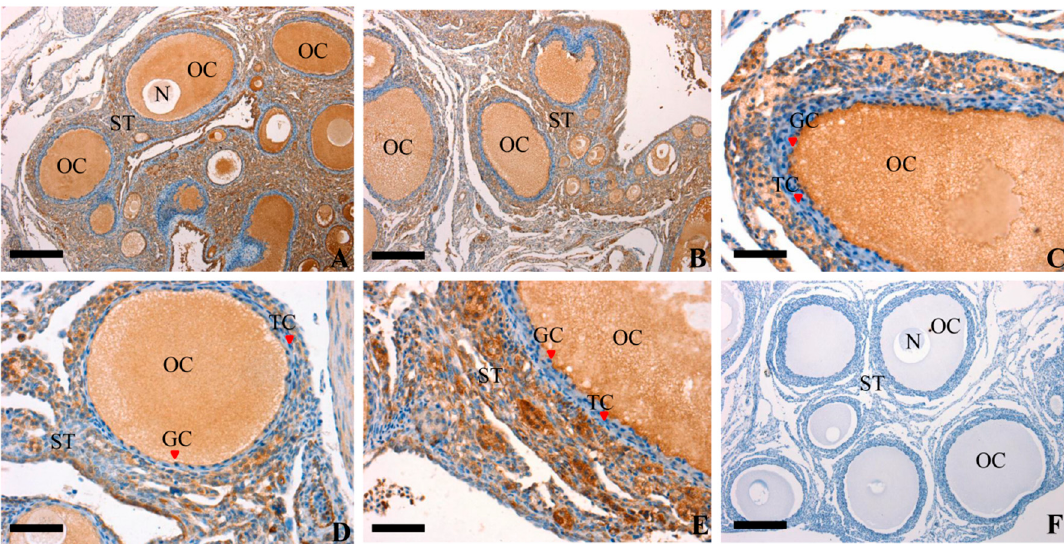
Figure 2. Representative photomicrographs of RAC1 protein immunolocalization (in brown) in the prehierarchical follicle of ovarian. Panel ( A ) and ( B ), oocytes and GCs were strongly stained within the different size of prehierarchical follicles; Panel ( C ) and ( D ), a larger developing prehierarchical follicles, which contains two or three layers of GCs; Panel ( E ), a larger prehierarchical follicles and more layers of GCs and thecal cells developing in this stage; Panel ( F ), RAC1 negative controls, which were treated with pre ‐ immune serum and no specific staining was observed. Oocyte (OC), granulosa cell (GC), theca cell (TC), stroma (ST) and nucleus (N) are indicated. Scale bar = 200 μ m ( A , B , F ); 100 μ m ( C , D , E ).